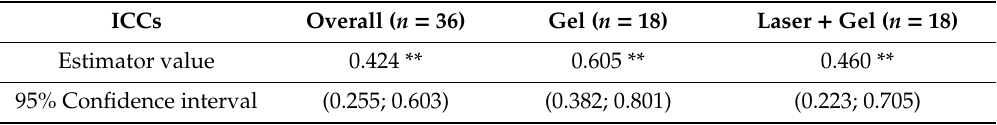
Table 3. Intraclass correlation coe ffi cients (ICCs) for VRS reliability data.